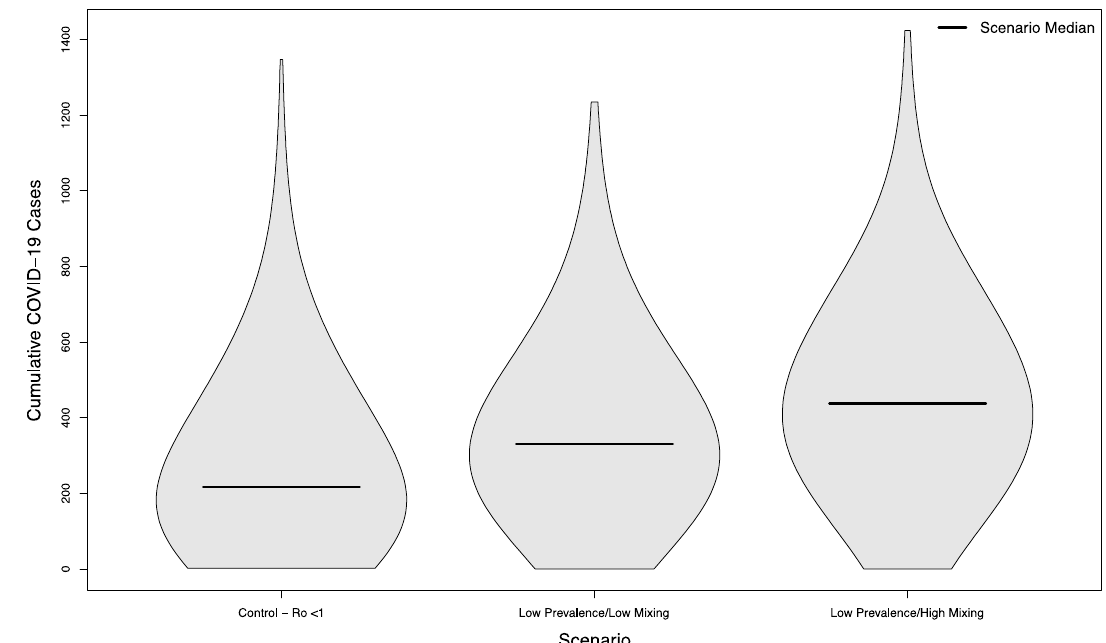
Figure 3. Distribution of cumulative COVID-19 cases in 1000 simulated university campuses with controlled epidemics, comparing a campus with no in-person sporting events to two scenarios where visitors come from a low prevalence area and mix with the campus community at a low rate or a high rate, respectively.